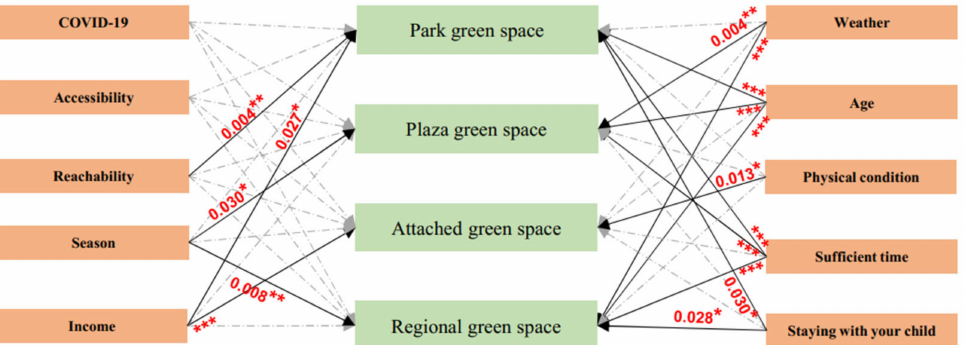
Figure 5. Final SEM. Solid lines indicate statistically significant pathways; dotted lines indicate statistically non-significant pathways. *, p < 0.05; **, p < 0.01; ***, p < 0.001. “Age” is one of the most important factors in residents’ preference for UGS because it significantly affects ( p < 0.001) three green space types. For park and plaza green space, the most selected options of the actual and ideal frequency among urban residents are “less than once a month” and “1–3 times per week” basically for all ages (Figure 6). For regional green space, people aged 25–59 have the same preference, while a small difference was shown between those aged 18–24. Attached green space had the highest actual frequency and ideal frequency. For the 40–59 group, the frequency was “1–3 times per week”. As age decreased, the actual frequency of the 25–39 group was “1–3 times per week”, while the ideal frequency was “everyday”. The actual frequency of the 18–24 group to attached green space was lower than the ideal frequency. In conclusion, the type of green space most affected by “age” was attached green space, followed by regional green space, which essentially had no impact on park green space and plaza green space.